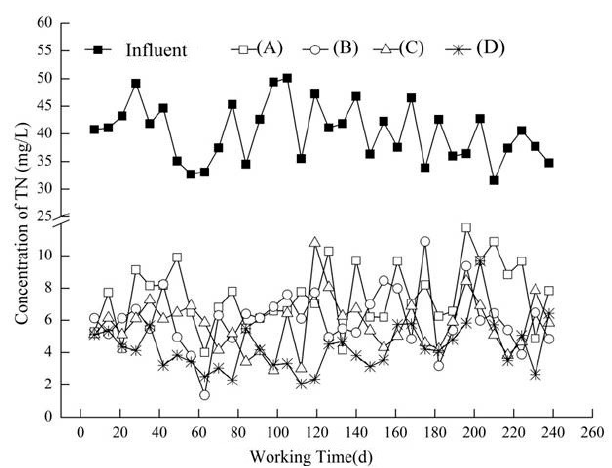
Figure 2. Removal rates of total nitrogen (TN) in the four different devices (A–D).